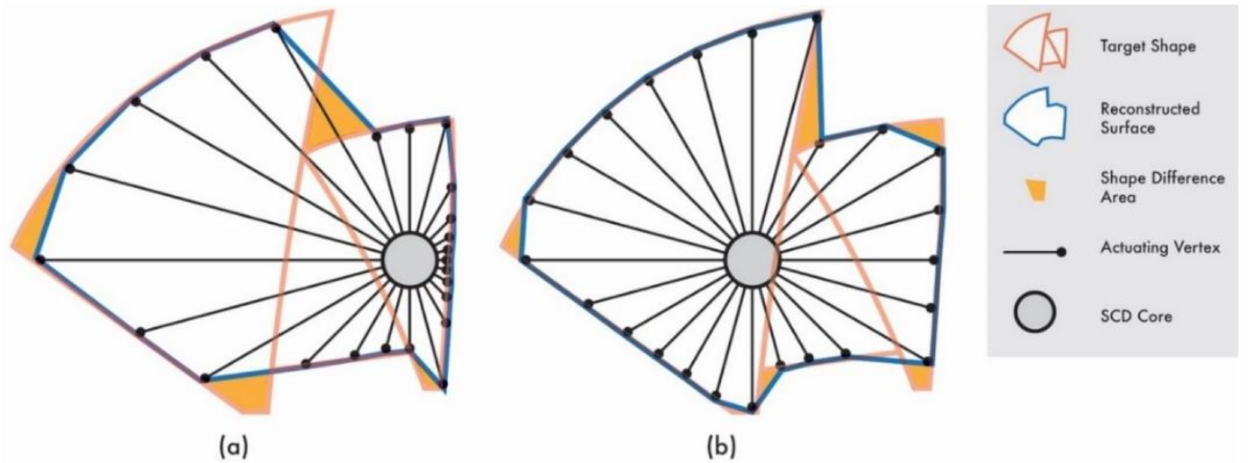
Figure 15. Comparison of actuating vertex density of the Sydney Opera House constructed using two different center positions ( a , b